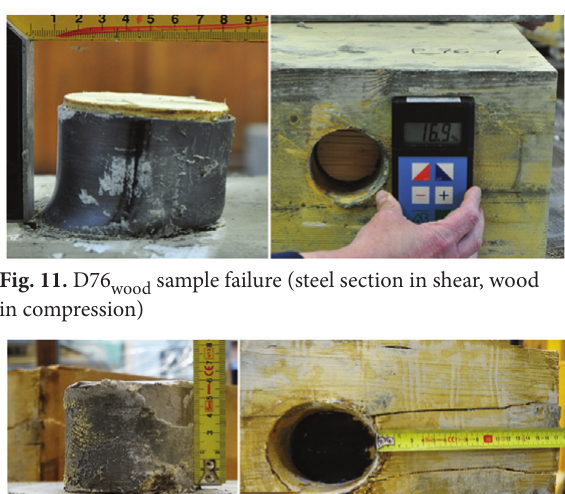
Fig. 10. D60 wood sample failure (steel tearing at extreme slip levels and wood in compression)